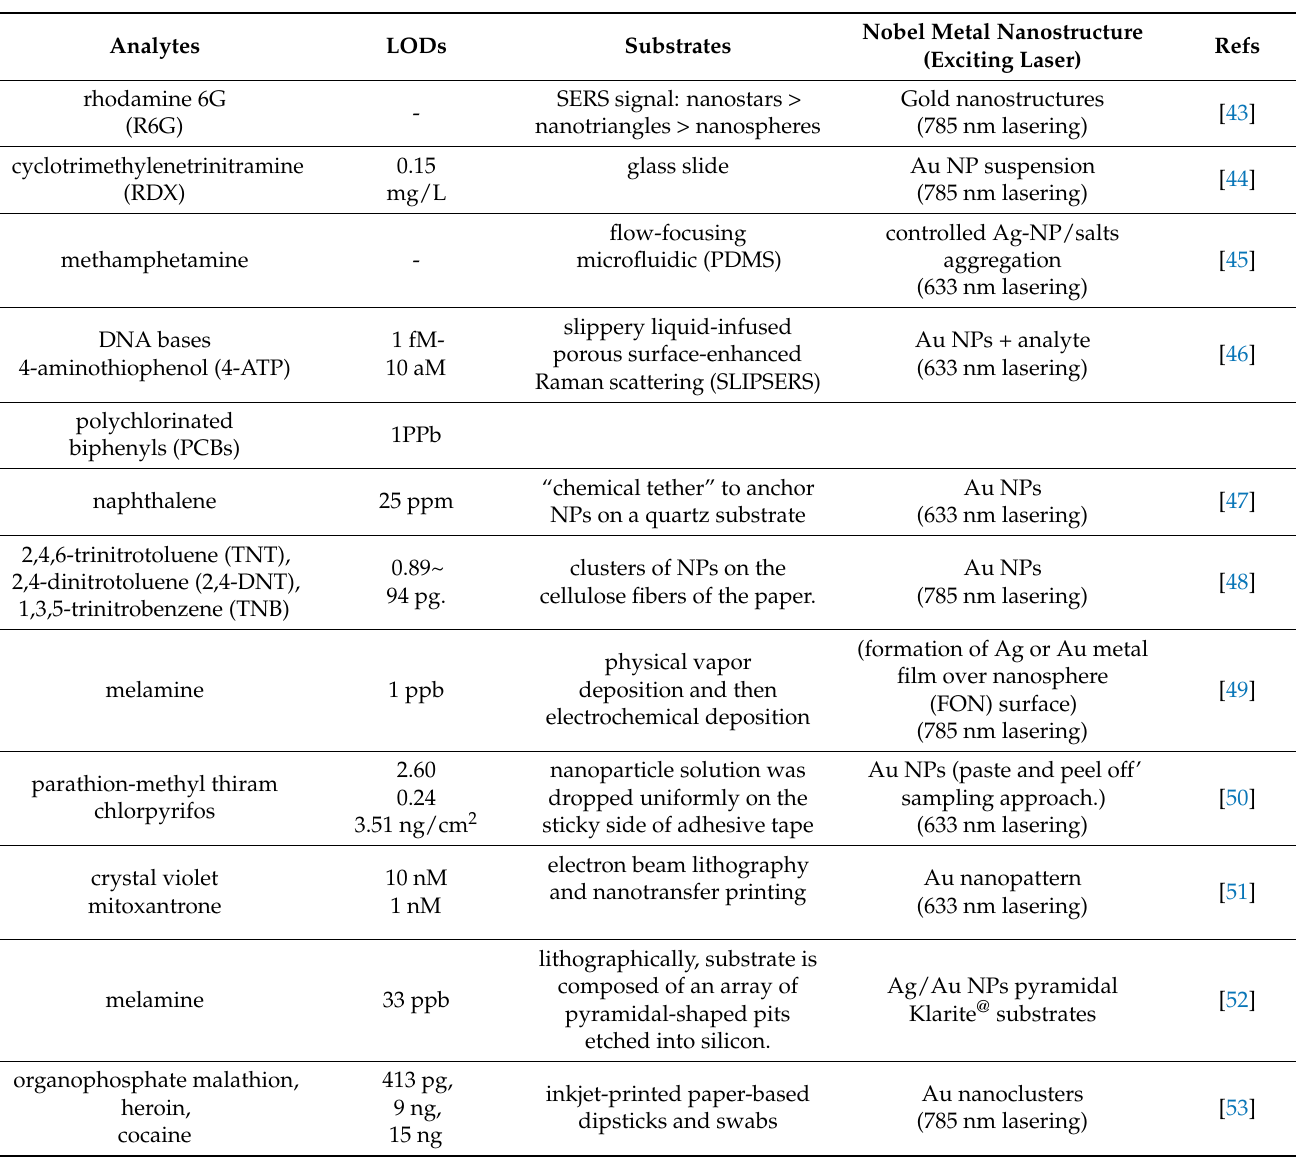
Table 2. Comparison of substrates and limits of detection (LODs) of various methods from the literature. * improve the discriminant